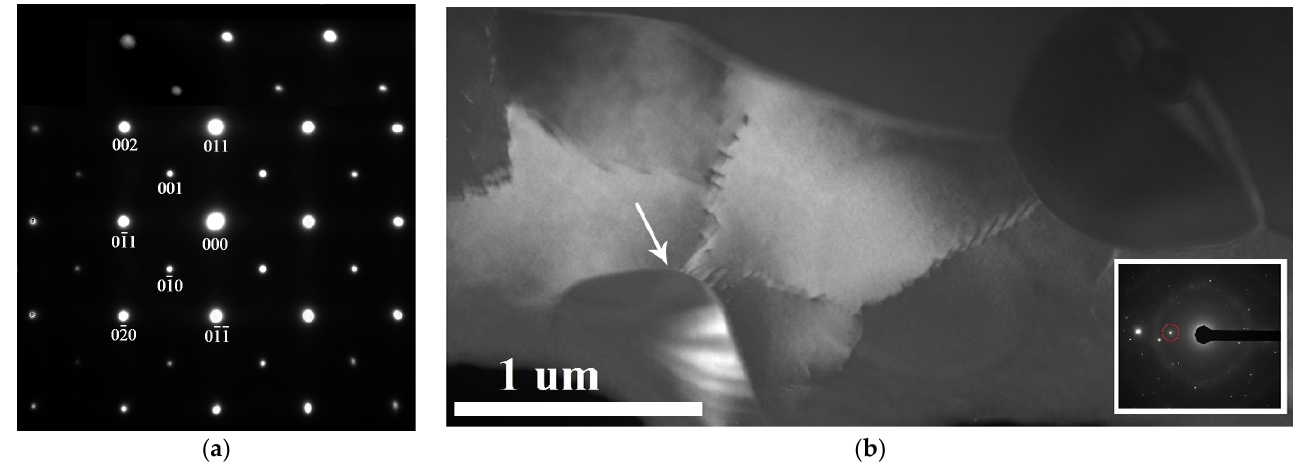
Figure 1. Diffraction pattern obtained from a section of the Ni 51 Ti 49 sample subjected to a tensile load: ( a ) atomically ordered structure B2; ( b ) dark-field TEM image of the lenticular crystal nucleation region at the junction of three grains obtained in the light of the selected reflex on the insert.